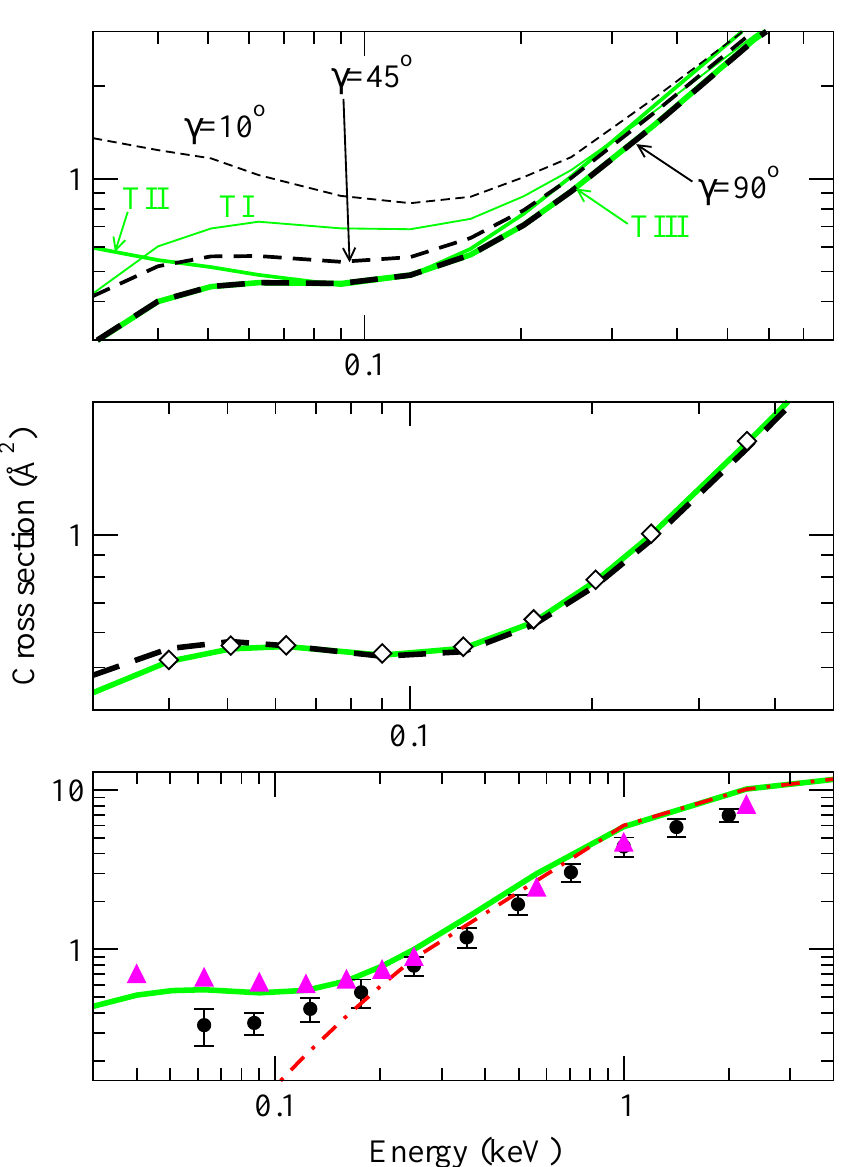
Figure 3: Charge transfer cross sections calculated using different approximations. Top panel: comparison between cross sections obtained for three characteristic trajectories (grey lines, σ ct σ ct and σ ct ) with those obtained with the isotropic approximation at three angles (dashed lines, II III σ ct ( γ = 10 ◦ ), σ ct ( γ = 45 ◦ ) and σ ct ( γ = 90 ◦ )), as labeled in the figure. Middle panel: compar- 0 0 0 iso iso iso ison between cross sections averaged over trajectories, σ ct (eq. (21), grey solid line), with those (eq. (24), dashed line), and with the isotropic result at γ averaged over isotropic results, σ ct iso ( (cid:51) ). Bottom panel: comparison between the trajectory average of the middle panel (grey solid line) with an isotropic calculation at γ = 45 ◦ using ab initio couplings and potentials (solid trian- 0 gles), a SEIKON calculation with DIM couplings and potentials at γ and the experimental results of [21]. Note the different scales in the